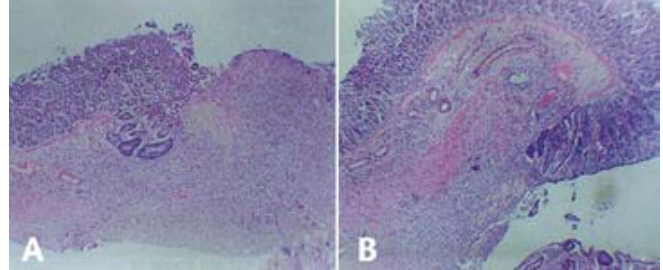
FIGURE 4 - Photomicrograph on the 7 th postoperative day. A . Polypropylene. B . Poliglecaprone 25.